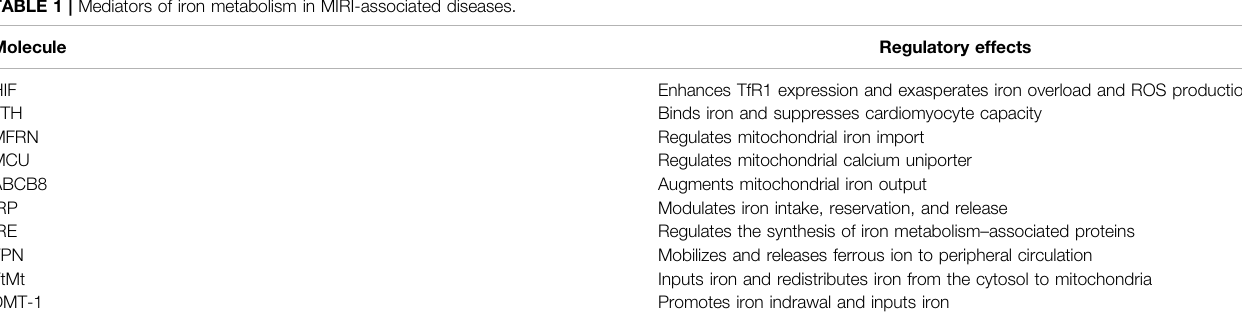
TABLE 1 | Mediators of iron metabolism in MIRI-associated diseases.